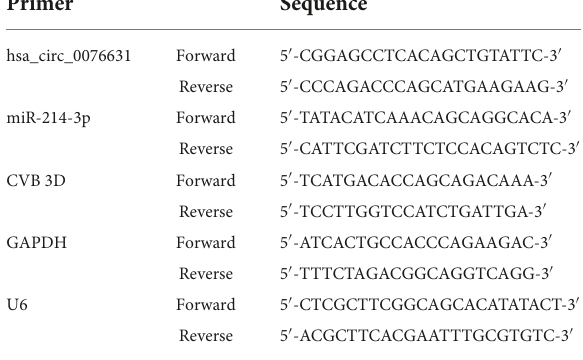
TABLE 1 PCR primer